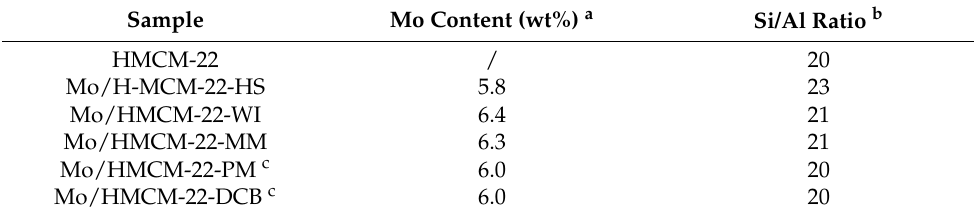
Table 1. Si/Al ratios and Mo contents for the HMCM-22 zeolite and Mo/HMCM-22 catalysts.